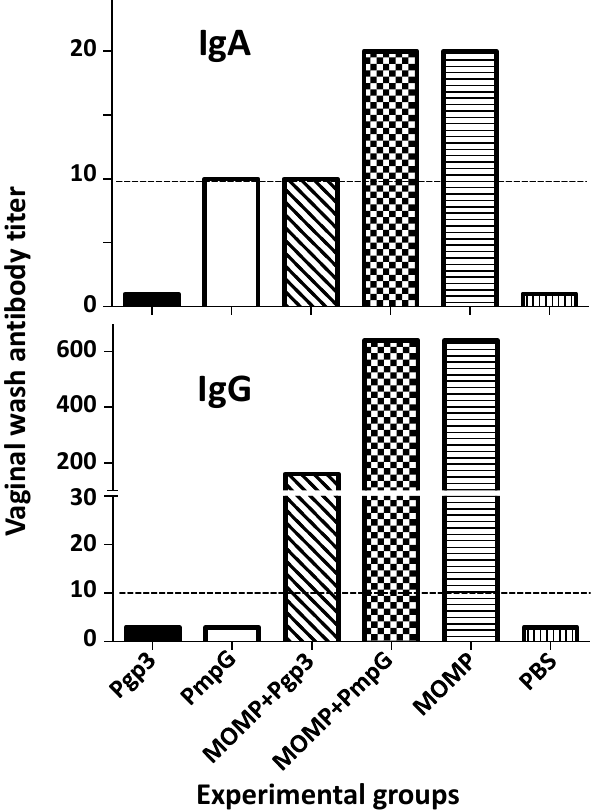
Figure 6. C. muridarum -specific IgA and IgG (GMT) in vaginal washes from vaccinated mice the day before the i.n. challenge. Vaginal washes were collected and pooled from each group of mice and the C. muridarum specific IgA and IgG titer determined using EB as the antigen in an ELISA. BLD (horizontal broken line) <